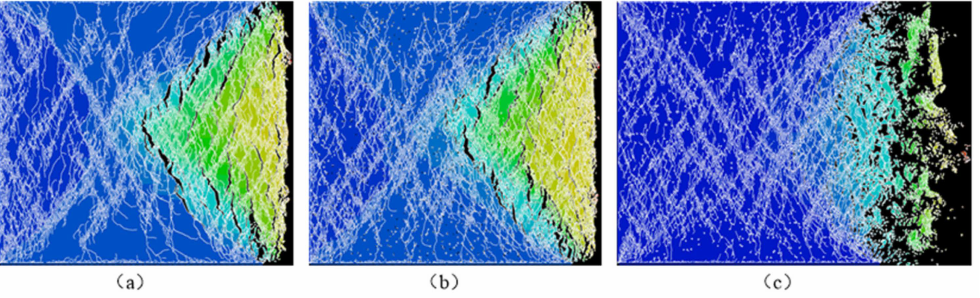
Figure 12. The failure result comparison of coal samples under different simulation conditions: ( a ) coal without pores; ( b ) coal with pores; and ( c ) coal with pore